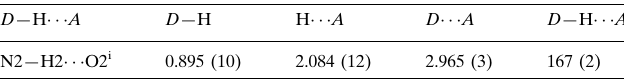
Hydrogen-bond geometry (A˚ , (cid:1)